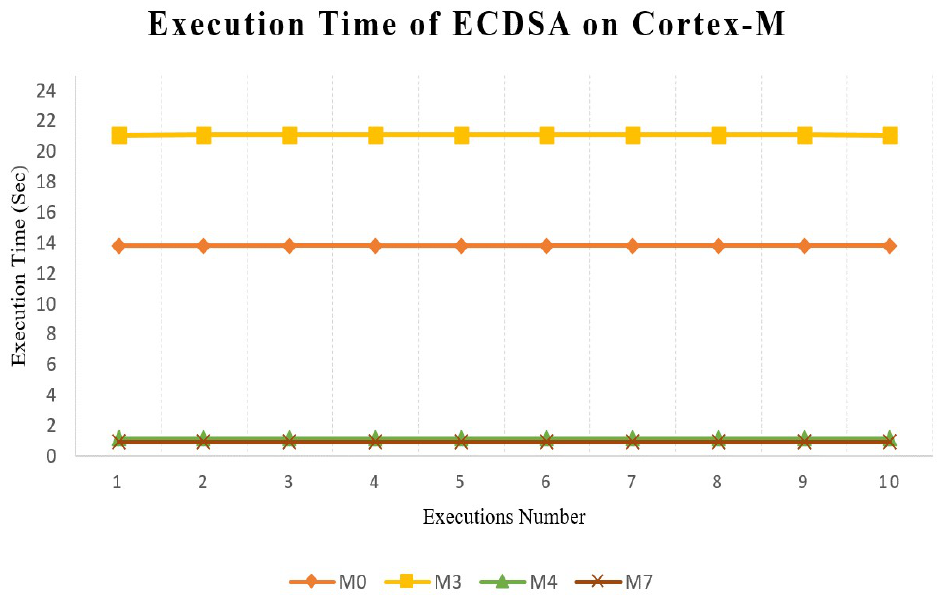
Figure 5. Execution time for each